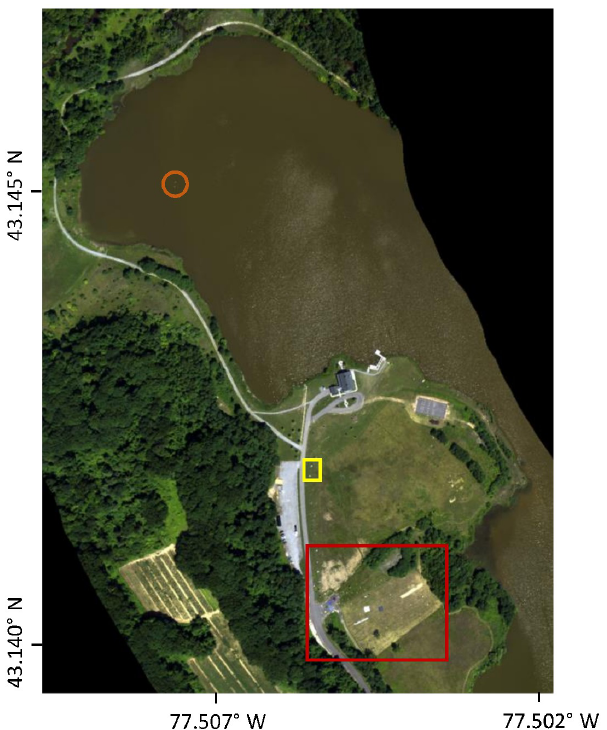
Figure 1. Study site as imaged by the airborne sensor (pseudo-RGB). Diffuse reflectance targets and calibration standards, as well as SPARC mirror targets, are visible in the primary target area (red square). Additional SPARC targets configured for satellite (yellow square) and airborne (orange circle) sensors were deployed in other locations around the study